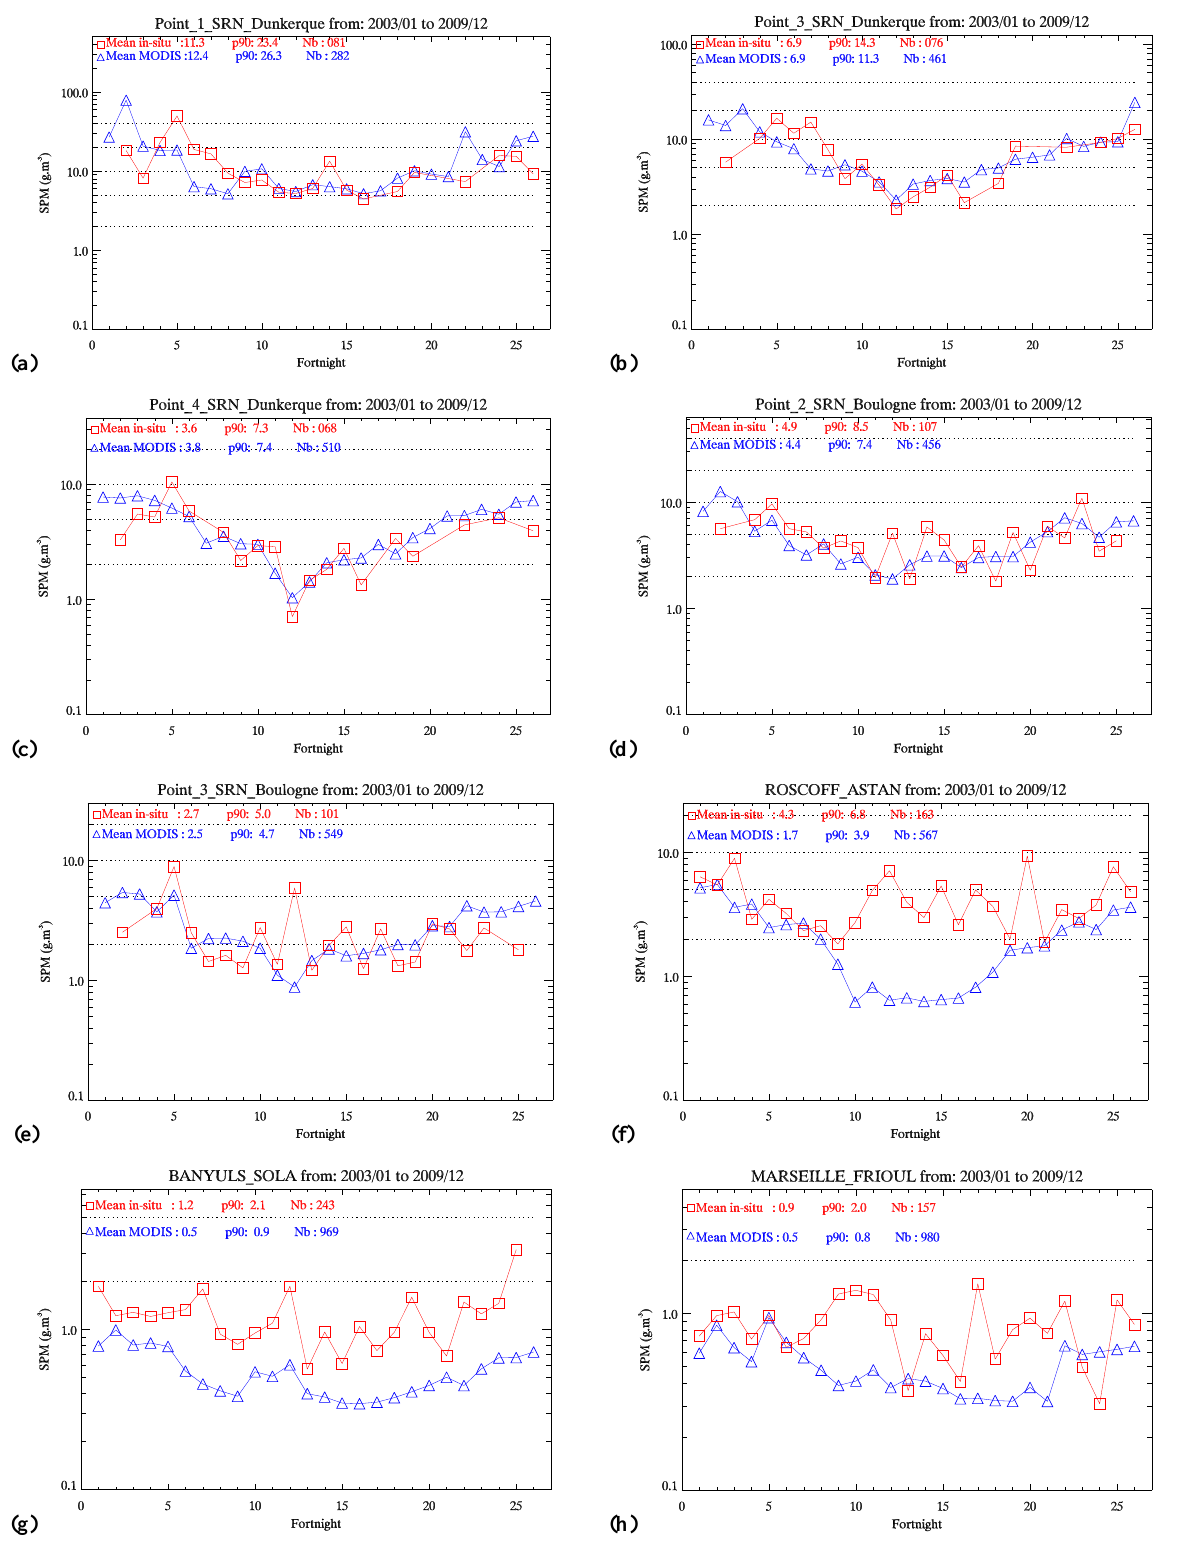
Fig. 7. The annual cycles of non-algal SPM at the 8 selected stations where it is measured. Statistics indicated on the graphs (mean, p90, Nb samples available) concern the productive season (March to